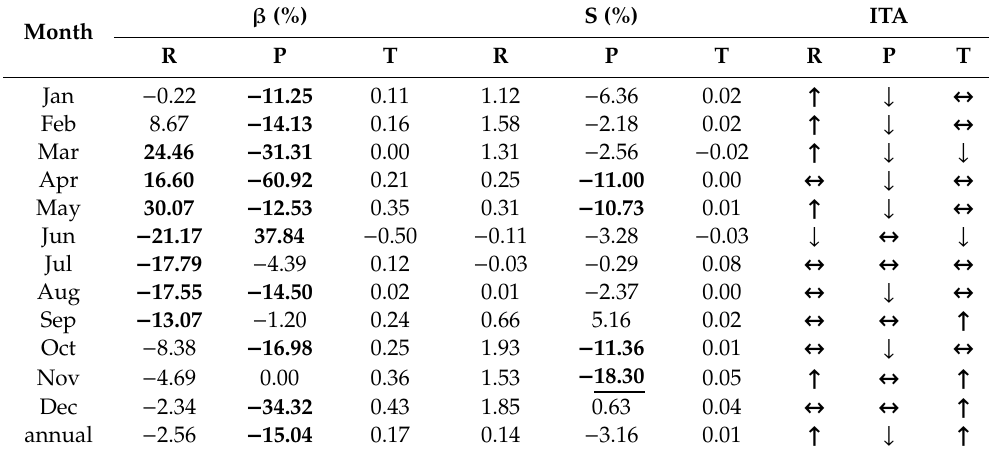
Table 3. Summary of the trend analysis of Zone II.